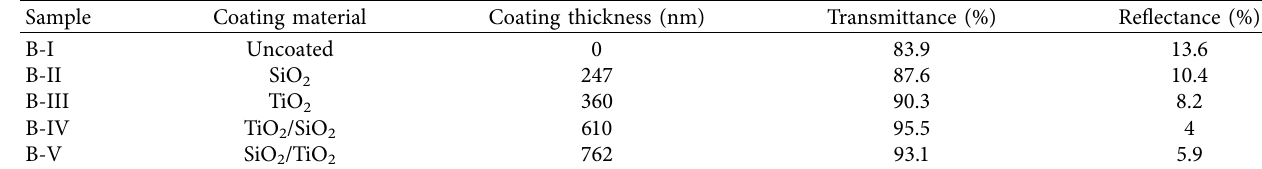
Table 2: Transmittance and reflectance of coated and uncoated solar cells.